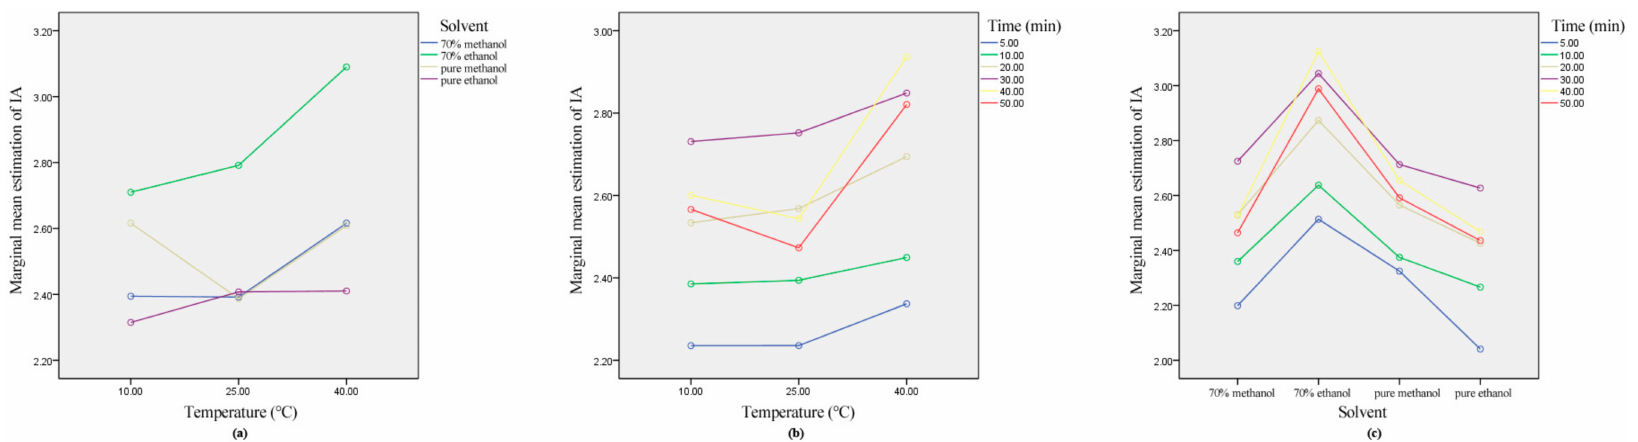
Figure 5. E ff ect of interaction on individual anthocyanins from blueberry pomace during ultrasound extraction course. Letters ( a – c ) represent interactions of solvent–temperature, temperature–time, and